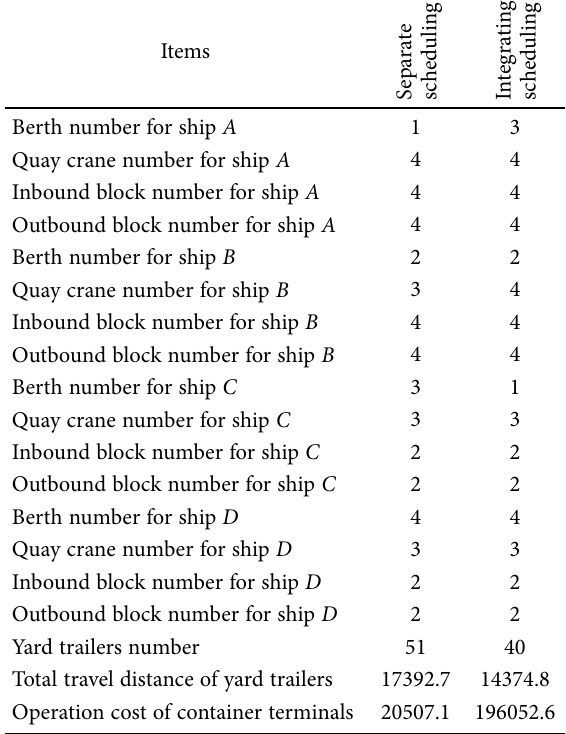
Table 4. Comparison of scheduling modes for container